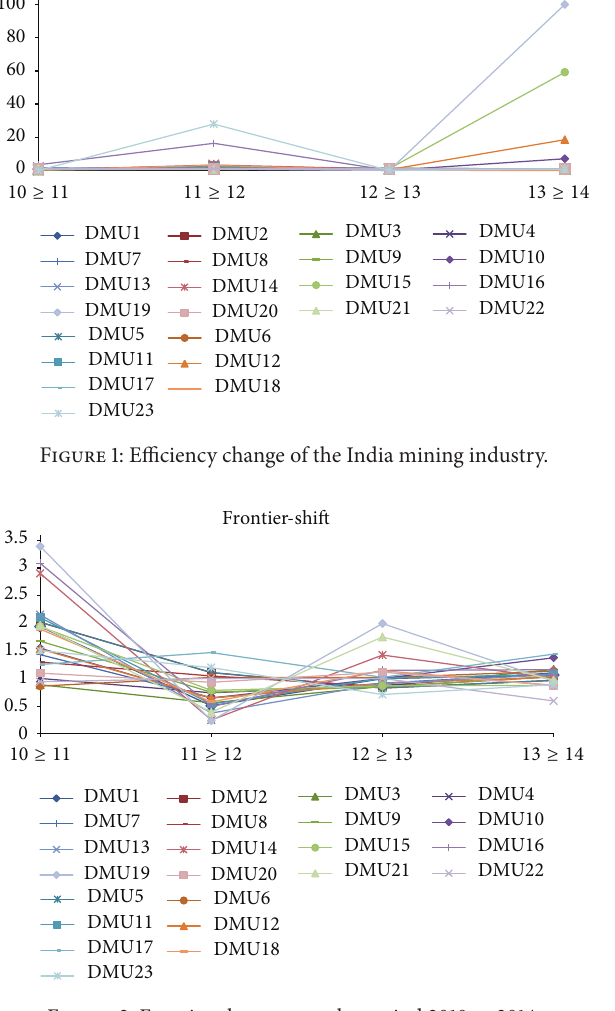
Figure 2: Frontier change over the period 2010 to 2014.